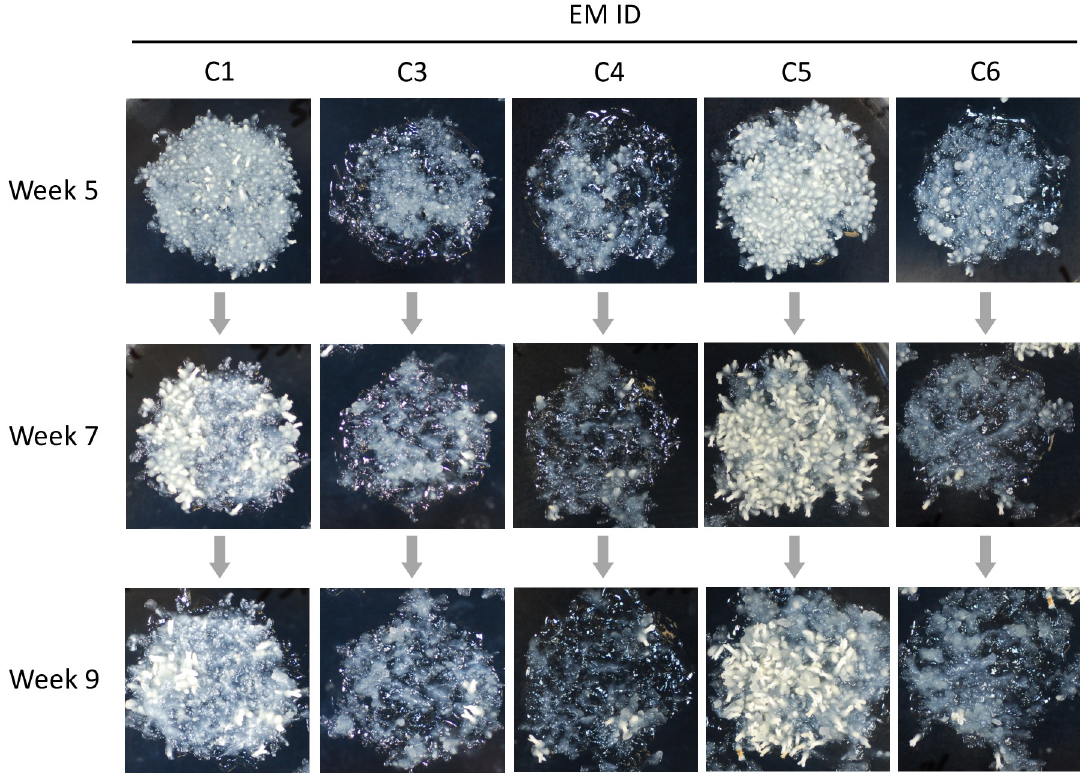
Fig 2. The five Cryptomeria japonica embryonal masses (EMs) induced from an identical cell line SSD-100 at 5, 7, and 9 weeks after maturation. The capacity to develop somatic embryos are different between EMs.